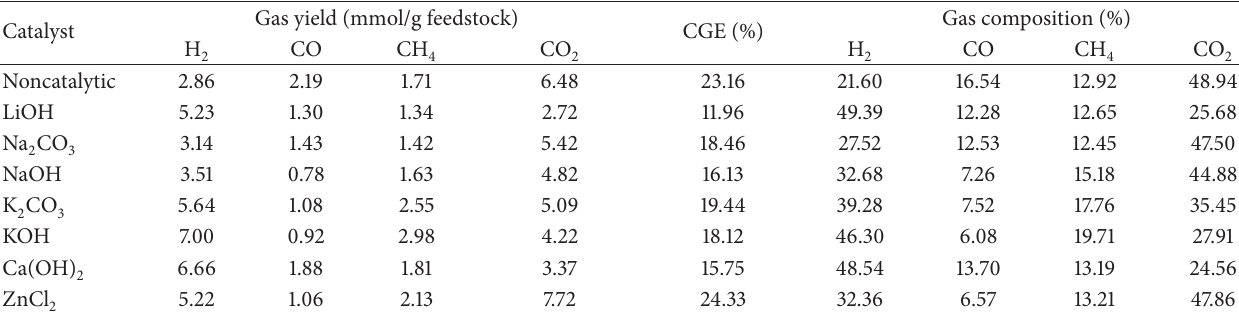
Table 4: Experimental results for different homogeneous